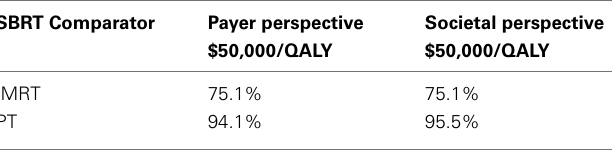
Table 7 | Probability of SBRT being cost-effective at the $50,000/QALY threshold.